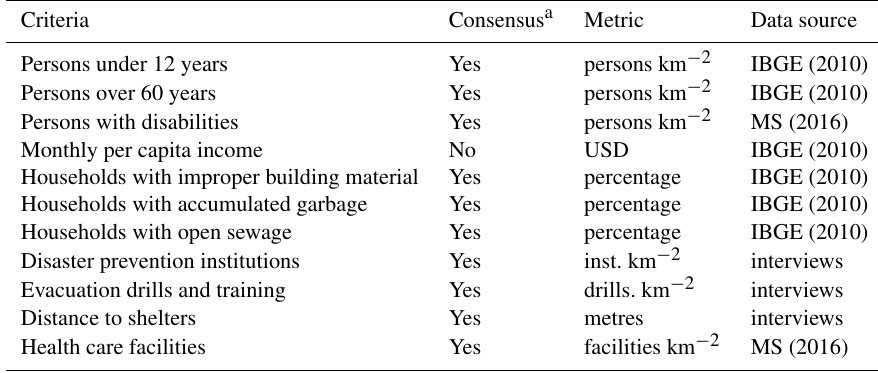
Table 1. Selected criteria, their respective data source and metrics used to measure them.